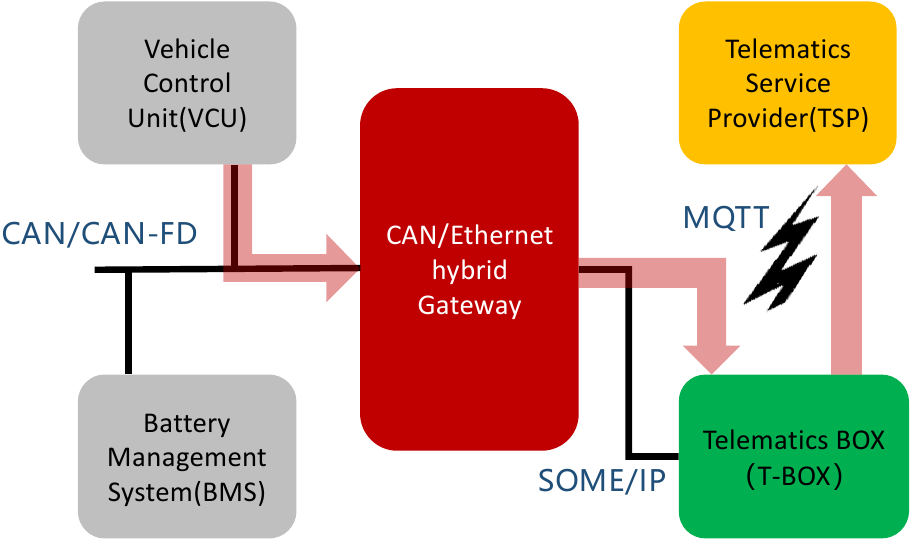
Figure 15. Application case of CAN/CANFD to SOME/IP.